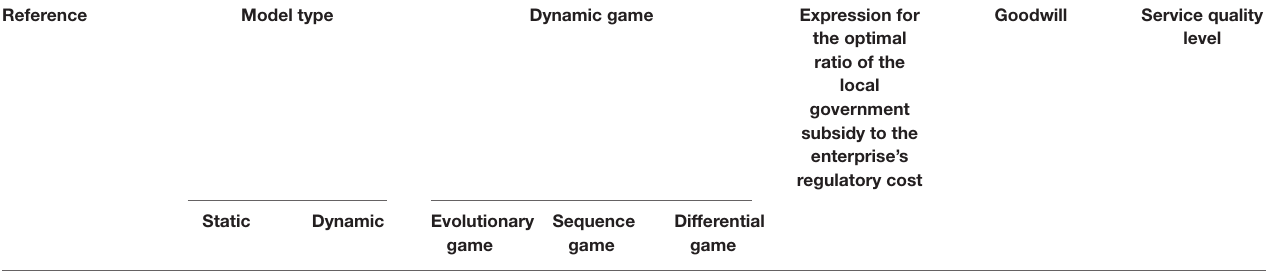
TABLE 1 | Summary of relevant